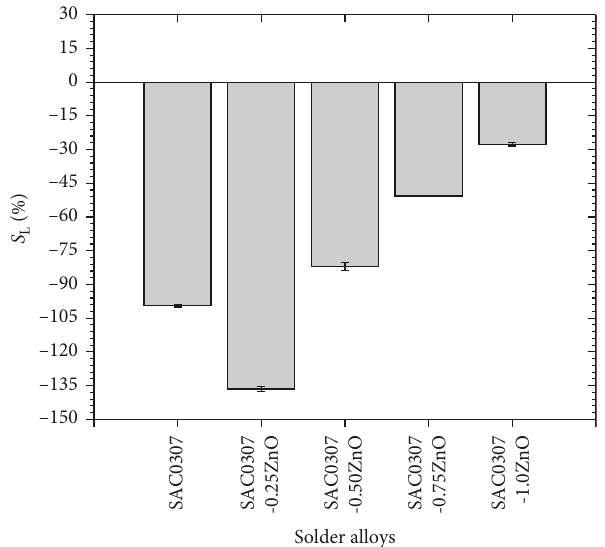
Figure 8: The slumping of the SAC0307-xZnO solders on the copper substrate at 150 ° C.